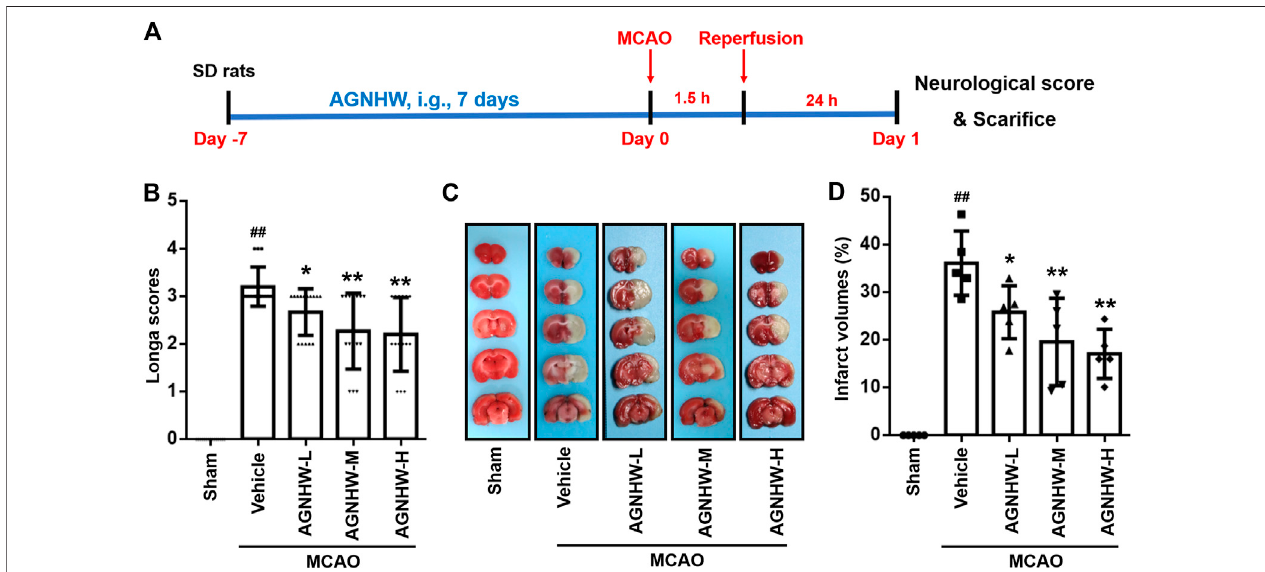
FIGURE1| AGNHWpre-treatmentamelioratedneurologicalde fi citanddecreasedinfarctsizeinMCAOratmodel (A) Illustration ofexperimental schedule. (B) The degree ofneurologicalfunction wasassessed by Zea long ’ s scoring on a fi ve-point scale 24 h after reperfusion ( n (cid:2) 15) (C,D) Infarct size wasmeasured byTTC staining 24 hafter reperfusion( n (cid:2) 5).Representativeimage (C) andstatisticalanalysisofresultsofTTCstaining (D) .Dataaremeans ± S.D. ## p < 0.01, compared withthesham group; * p < 0.05 and ** p < 0.01, compared with the vehicle